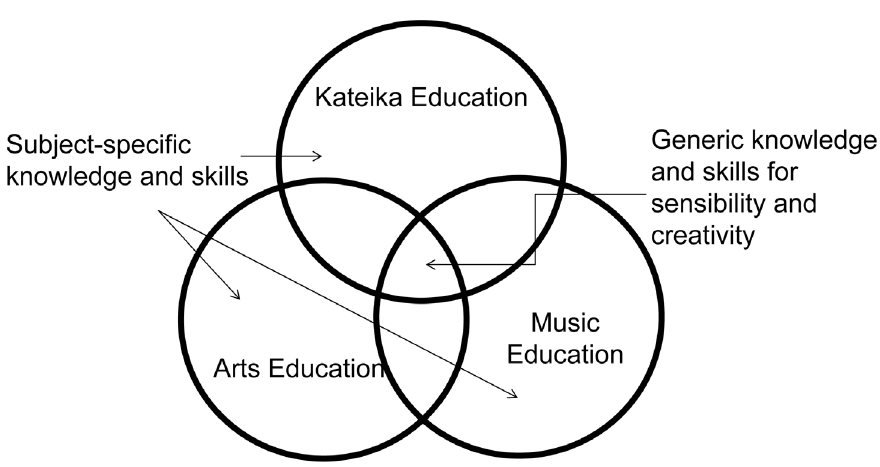
Figure 1: Sensibility and creativity as generic knowledge and